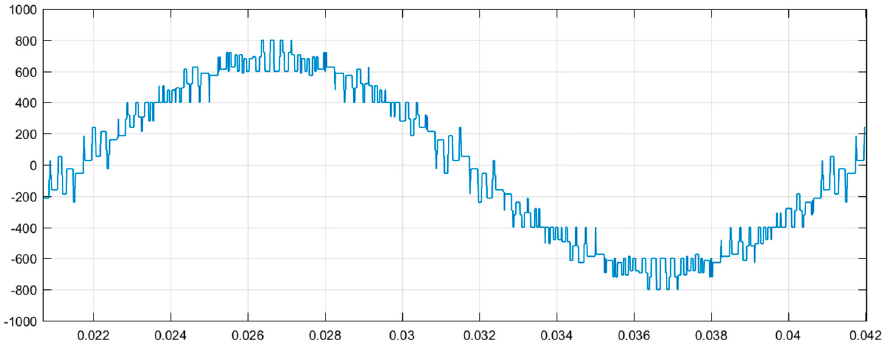
Figure 21. Three-phase four H-bridge CHB line voltage for PS PWM and worst switching of non-equal sources.